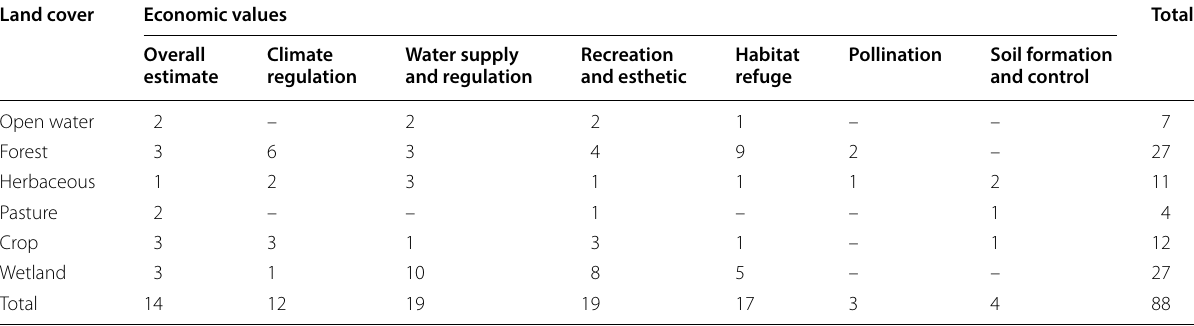
Table 1 Value transfer studies summary Land cover